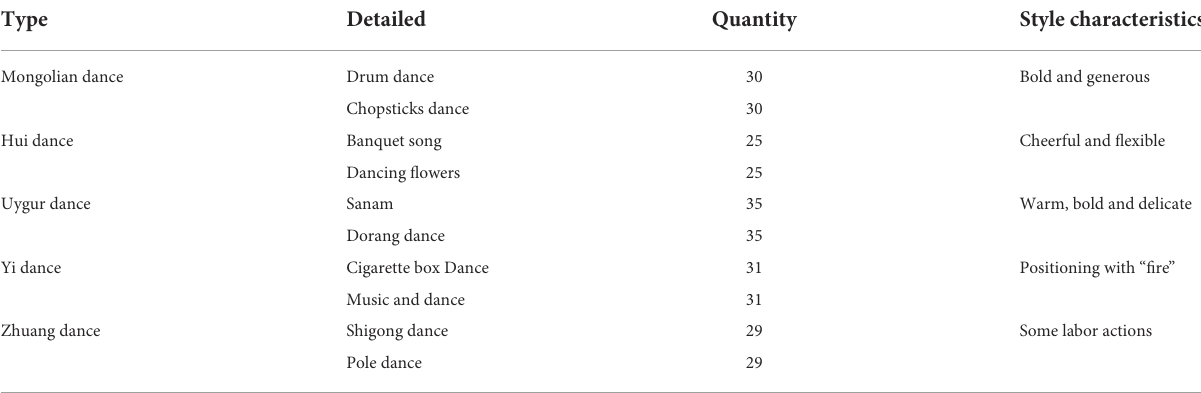
TABLE 1 Selected dance types, nationalities, quantities and